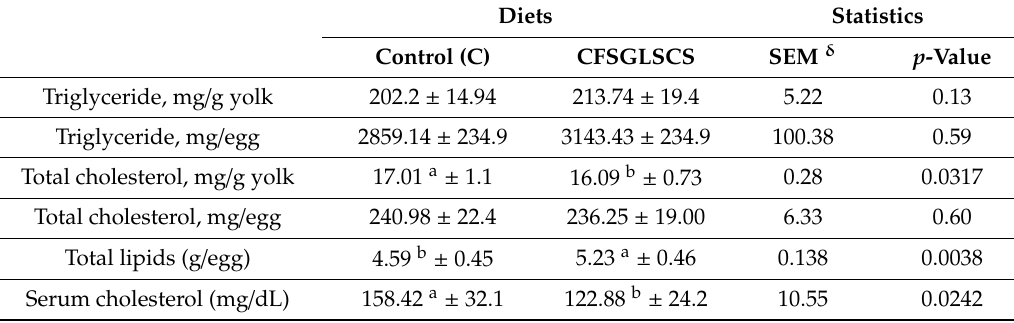
Table 4. E ff ects of various diets on lipids profile.